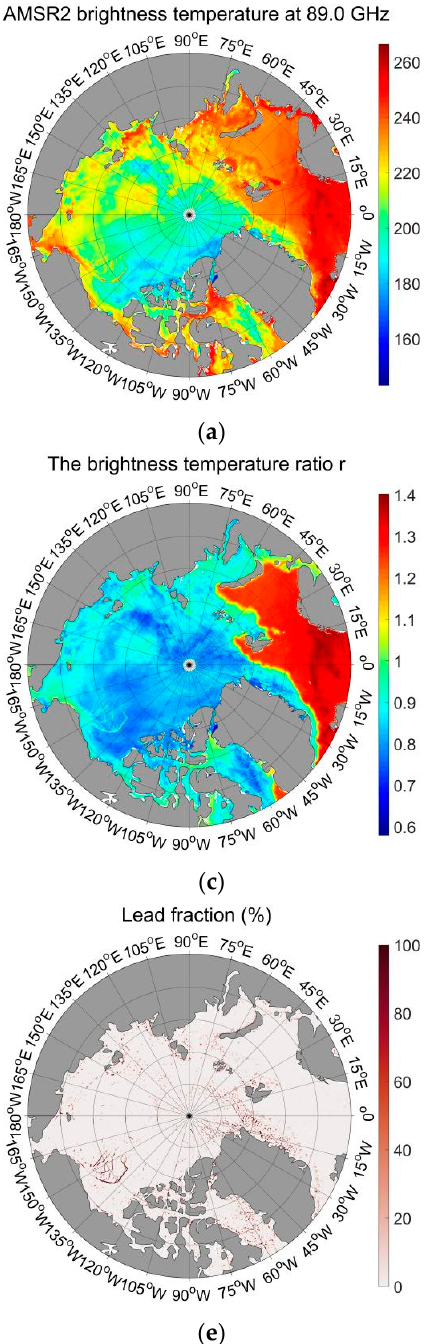
Figure 1. Spatial patterns of the variables involved in the lead detection algorithm on 23 February 2013. ( a ) Vertically polarized brightness temperature at 89.0 GHz, ( b ) vertically polarized brightness temperature at 18.7 GHz, ( c ) brightness temperature ratio, ( d ) brightness temperature ratio anomaly, and ( e ) lead fraction. Unit of brightness temperature is K.